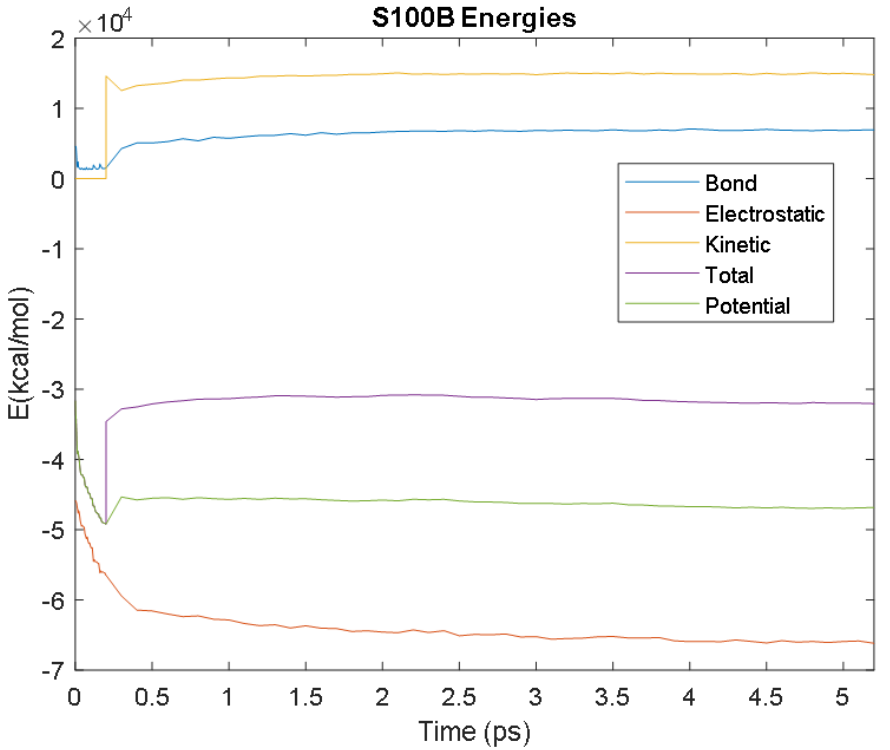
Figure 27. A plot of S100B’s bond, electrostatic, kinetic, total, and potential energies.